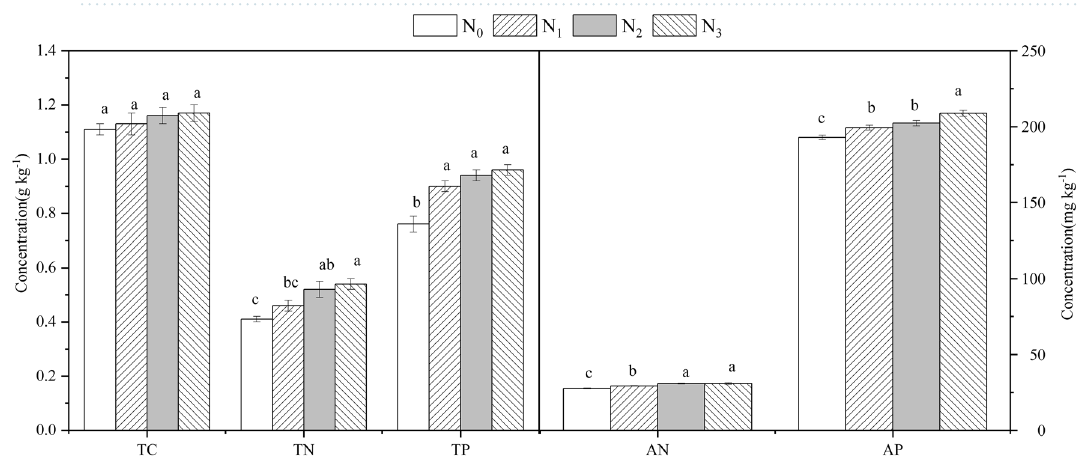
Figure 4. Effects of N addition on soil nutrient concentrations of R. soongorica . Error bars represent SE (n = 6). Different letters above bars indicate significant differences at P <